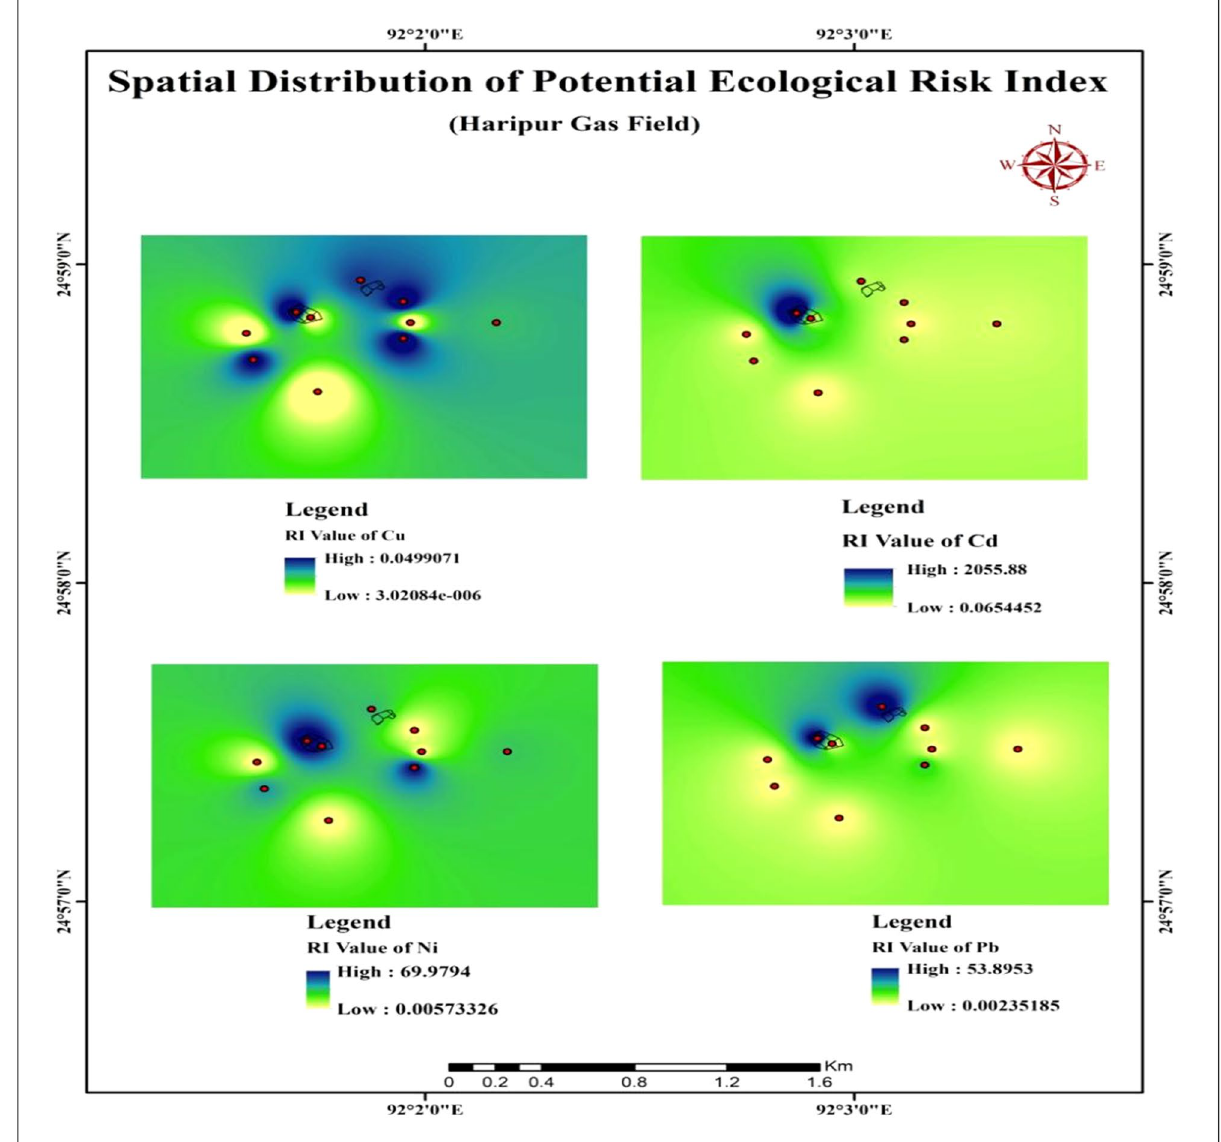
Figure 6. A map of the spatial distribution of potential ecological risk threats in the study area.